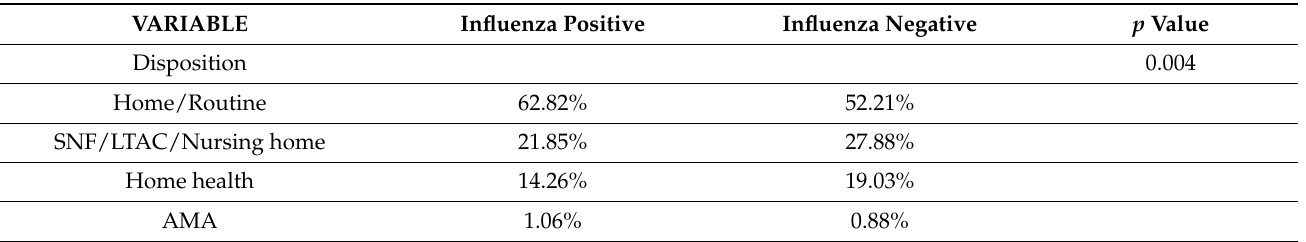
Figure 1. Influenza and COVID-19 patient in-hospital outcomes. SNF = skilled nursing facility, Figure 1: Influenza and COVID-19 patient in-hospital outcomes. SNF= skilled nursing facility, LTAC = Long-term acute LTAC = Long-term acute care, AMA = against medical advice. care, AMA = against medical advice Table 5. In-hospital outcomes for propensity 1:1 matched sample. SNF= skilled nursing facility, Table 5. In-hospital outcomes for propensity 1:1 matched sample. SNF = skilled nursing facility, LTAC = Long-term acute care, AMA = against medical advice LTAC = Long-term acute care, AMA = against medical